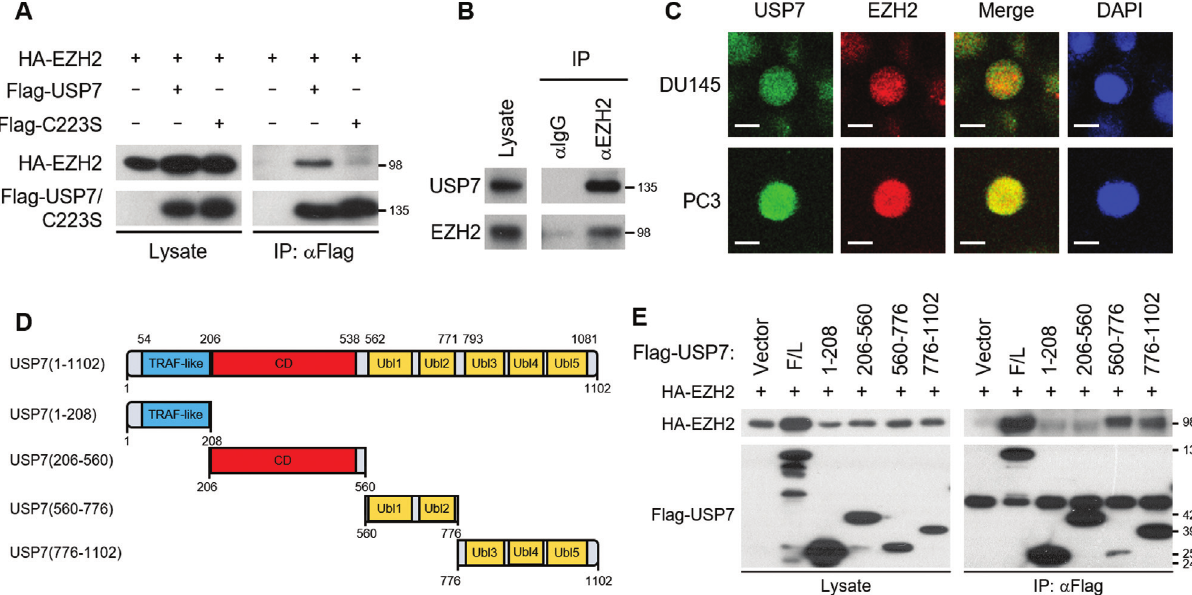
Figure 1 - USP7 interacts with EZH2. (A) HA-EZH2 was expressed in HEK293T cells with Flag-USP7 or Flag-USP7 C223S. Cell lysates were immunoprecipitated with anti-Flag antibody and immunoblotted with anti-Flag or anti-HA antibody. (B) Endogenous interaction of USP7 and EZH2. DU145 cell lysates were immunoprecipitated with normal IgG or anti-EZH2 antibody and immunoblotted with anti-USP7 or anti-EZH2 antibody. (C) Immunofluorescence staining of USP7 and EZH2 in DU145 or PC3 cells. USP7 was stained green and EZH2 was stained red. The blue signal represents nuclear DNA stained by DAPI. The bar indicates 10 (cid:2) m. (D) Schematic representation of the USP7 deletion mutants. TRAF-like, TNF recep- tor-associated factor (TRAF)-like N-terminal domain; CD, catalytic domain; Ubl, Ub-like domain. (E) HA-EZH2 was expressed in HEK293T cells in combination with each of the Flag-tagged USP7 deletion mutants. Cell lysates were immunoprecipitated with anti-Flag antibody and immunoblotted to detect HA-EZH2 and Flag-tagged USP7 deletion